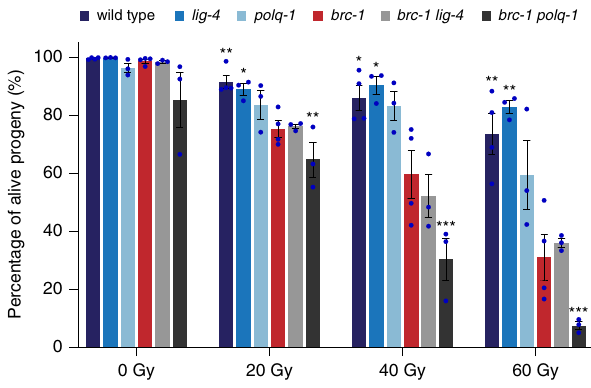
Fig. 4 Worms lacking BRC-1 and POLQ-1 are hypersensitive to ionising irradiation (IR). Wild type (dark blue), lig- 4 (blue), polq-1 (light blue), brc-1 (red), brc-1 lig-4 (grey) and brc-1 polq-1 (dark grey) L4 larvae were exposed to 0, 20, 40 or 60 Gy IR ( n = 3, wild type and brc-1: n = 4). Three days after irradiation, the numbers of alive offspring versus unviable eggs were quanti fi ed. The average survival in each experiment is represented in blue dots. Statistical analysis shows signi fi cant differential loss of viability between brc-1 polq-1 and brc-1 animals (two-tailed t -tests vs. brc-1 mutant * P < 0.05; ** P < 0.01, *** P < 0.001). Error bars represent